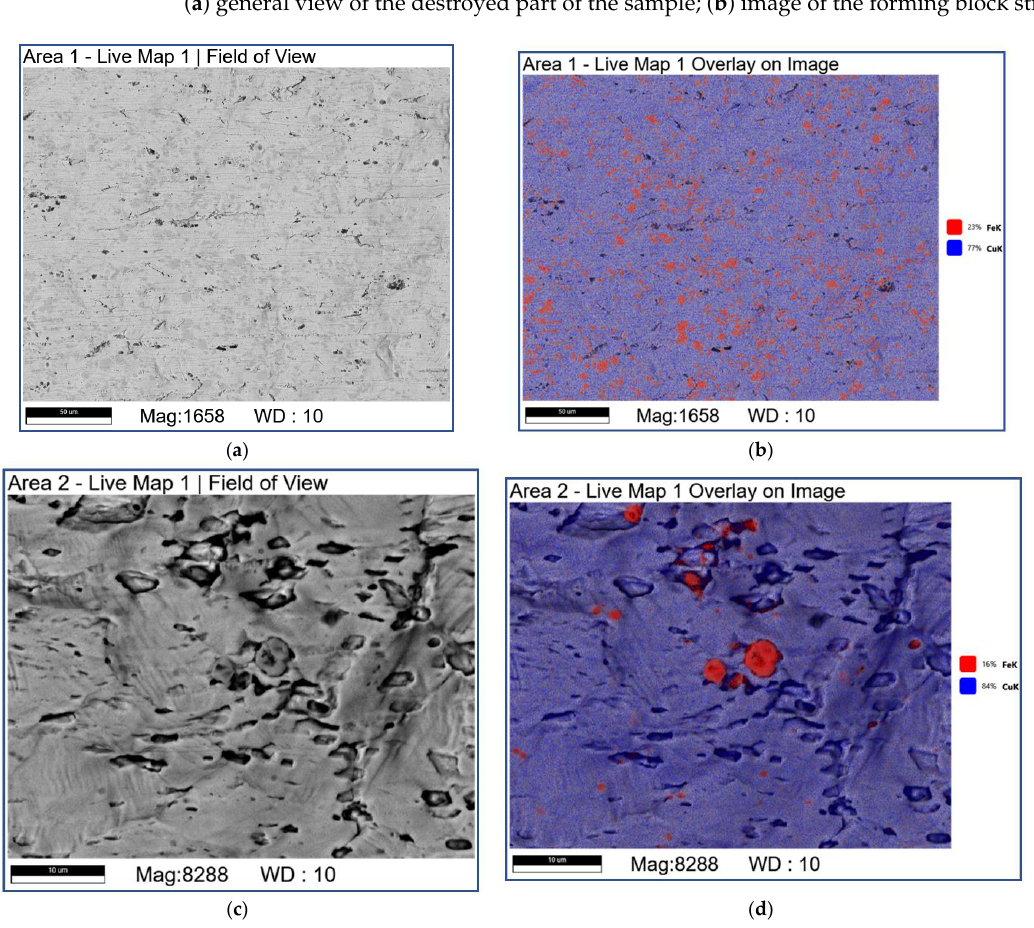
Figure 21. SEM BSE images ( a , c ) and layered EDS images ( b , d ) of the “copper − steel” sample after tensile testing in the neck area.